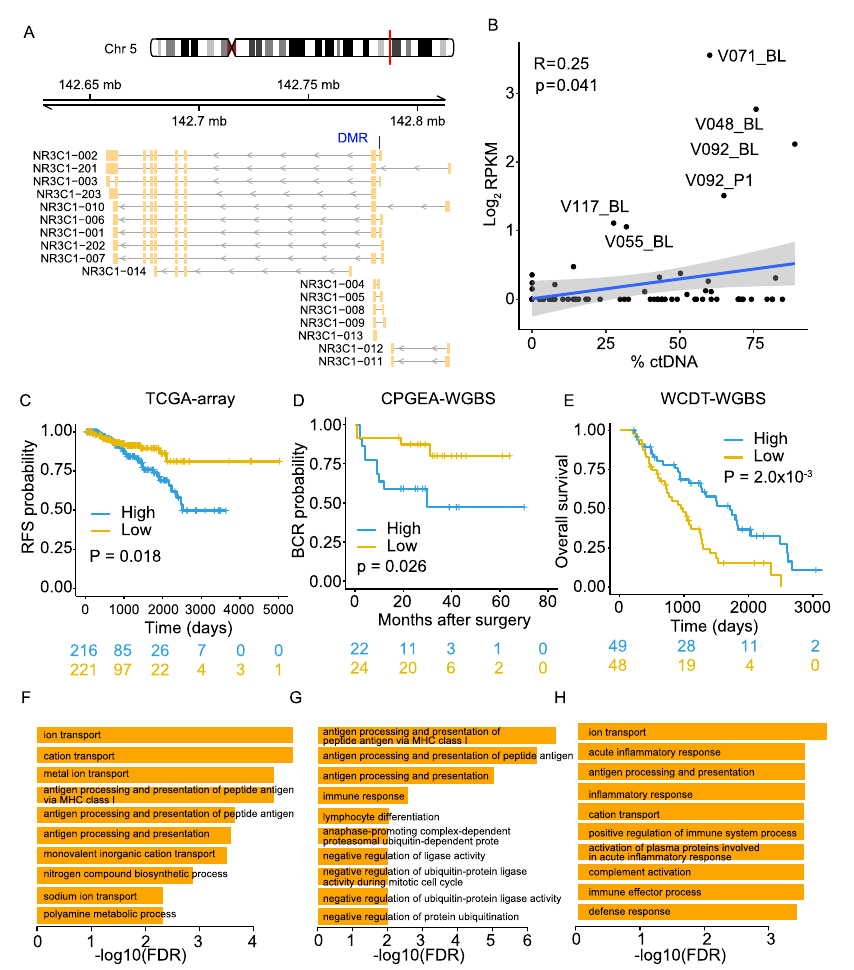
Fig.3|DifferentialmethylationinGRgeneassociatesitsalteredroleinmCRPC. A Schematics illustrating GR gene (NR2C1) and its different isoforms. Blue bar indicates the identi fi ed outlier DMR. B Pearson correlation between GR site methylation level and %ctDNA in VPC cohort. P value was calculated using two- sided t test. Blue line represents a fi tted linear model of the data and shading around the fi tted line represents 0.95 CI. Association between GR site methylation anddiseaseoutcomeintheCancerGenomeAtlas(TCGA)( C ),theChineseProstate